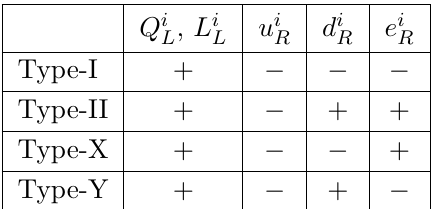
Table 1 . The charge assignments of the Z 4 symmetry for the SM fermions, where Q i d i , and e i are the i -th generation of the left-handed quark, the left-handed lepton, the right- R R handed up-type quark, the right-handed down-type quark, and the right-handed charged lepton, respectively ( i = 1 ; 2 ;